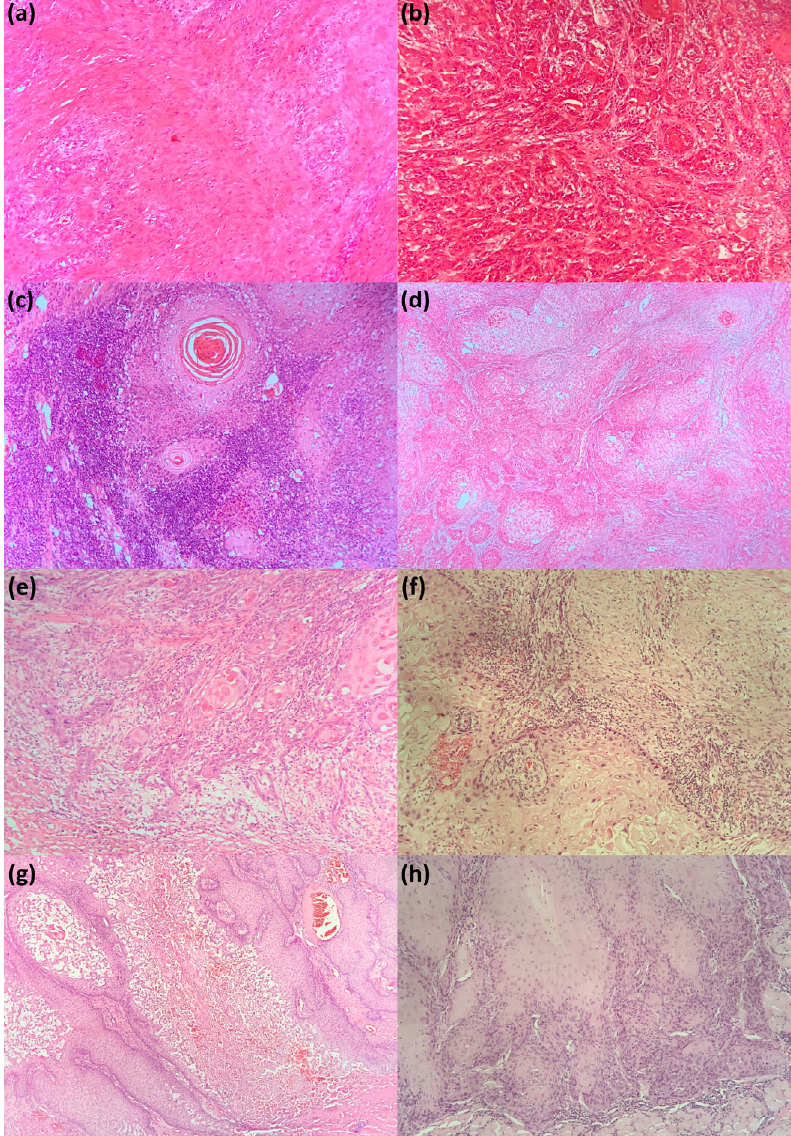
Figure 1. Histological features in SCC: ( a ) intense desmoplastic reaction (tumor/stroma ratio < 1) in non-keratinizing SCC; HE, original magnification 20×; ( b ) poor desmoplastic reaction (tumor/stroma ≥ 1) in moderately differentiated SCC; HE, original magnification 10×; ( c ) abundant immune infiltrate in keratinizing, well-differentiated SCC; HE, original magnification თ ; ( d ) absence of tumor-infiltrating lymphocytes in moderately differentiated SCC, HE, and original magnification 4×; ( e ) high tumor-budding activity in moderately differentiated SCC; HE, original magnification 10 ×; ( f ) low tumor-budding activity in moderately differentiated SCC; HE, original magnification 10 ×; ( g ) extended necrotic areas in moderately differentiated SCC; HE, original magnification 20×; and ( h ) absence of necrotic areas in moderately differentiated SCC, keratinizing SCC; HE, original magnification 20×. SCC: Squamous cell carcinoma; HE: hematoxylin-eosin.